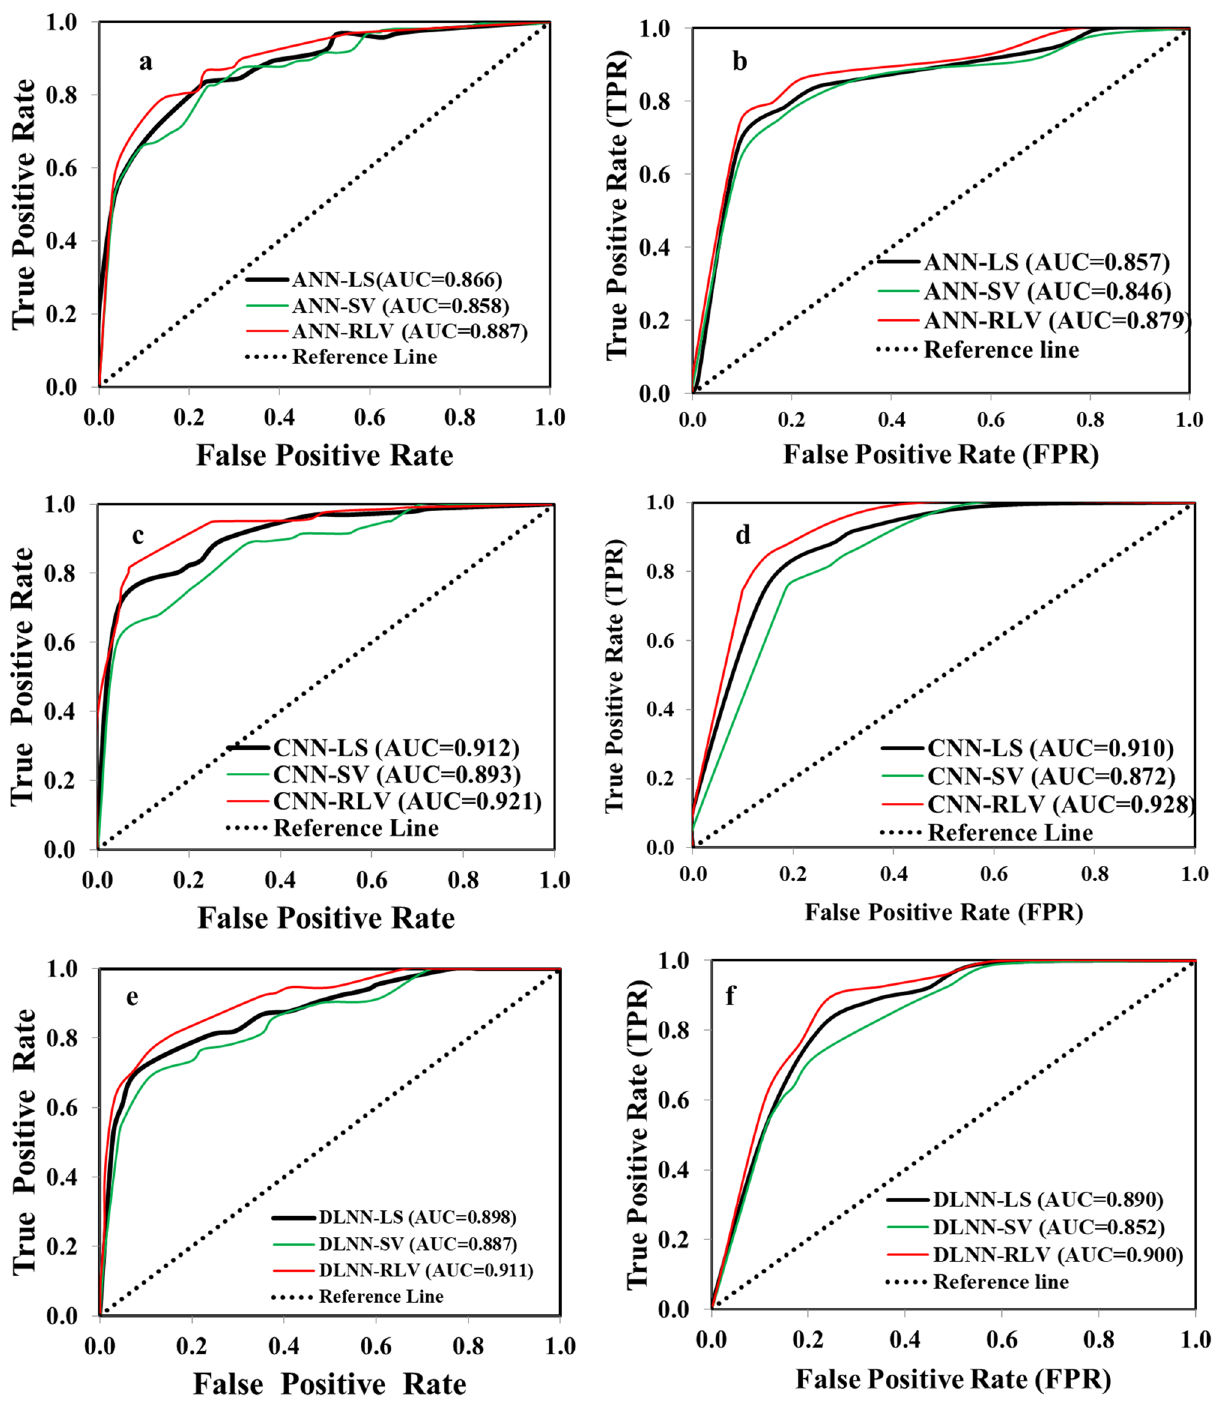
Figure 11. ROC curves used for validation of landslide vulnerability models: ( a ) ANN-LS, ANN-SV and ANN-RLV using Training, ( b ) ANN-LS, ANN-SV and ANN-RLV using validation datasets, ( c ) CNN-LS, CNN-SV and CNN-RLV using Training, ( d ) CNN-LS, CNN-SV and CNN-RLV using validation, ( e ) DLNN-LS, DLNN-SV and DLNN-RLV using training, ( f ) DLNN-LS, DLNN-SV and DLNN-RLV using validation